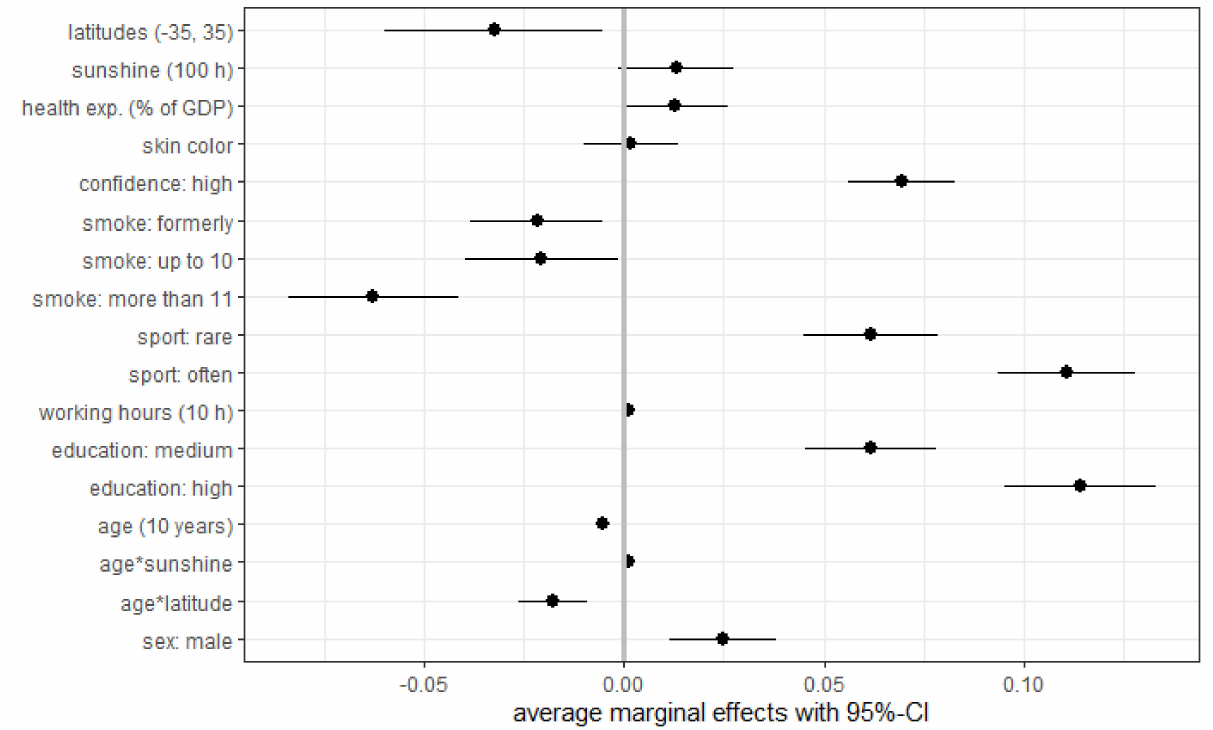
Figure 5. Coefficient plot of Varying intercepts constant slope model estimates including all control variables, but without mediation for comparison, health exp. (% of GDP) = domestic general gov. health expenditure (% of GDP), ISSP 2011, own calculation, N =